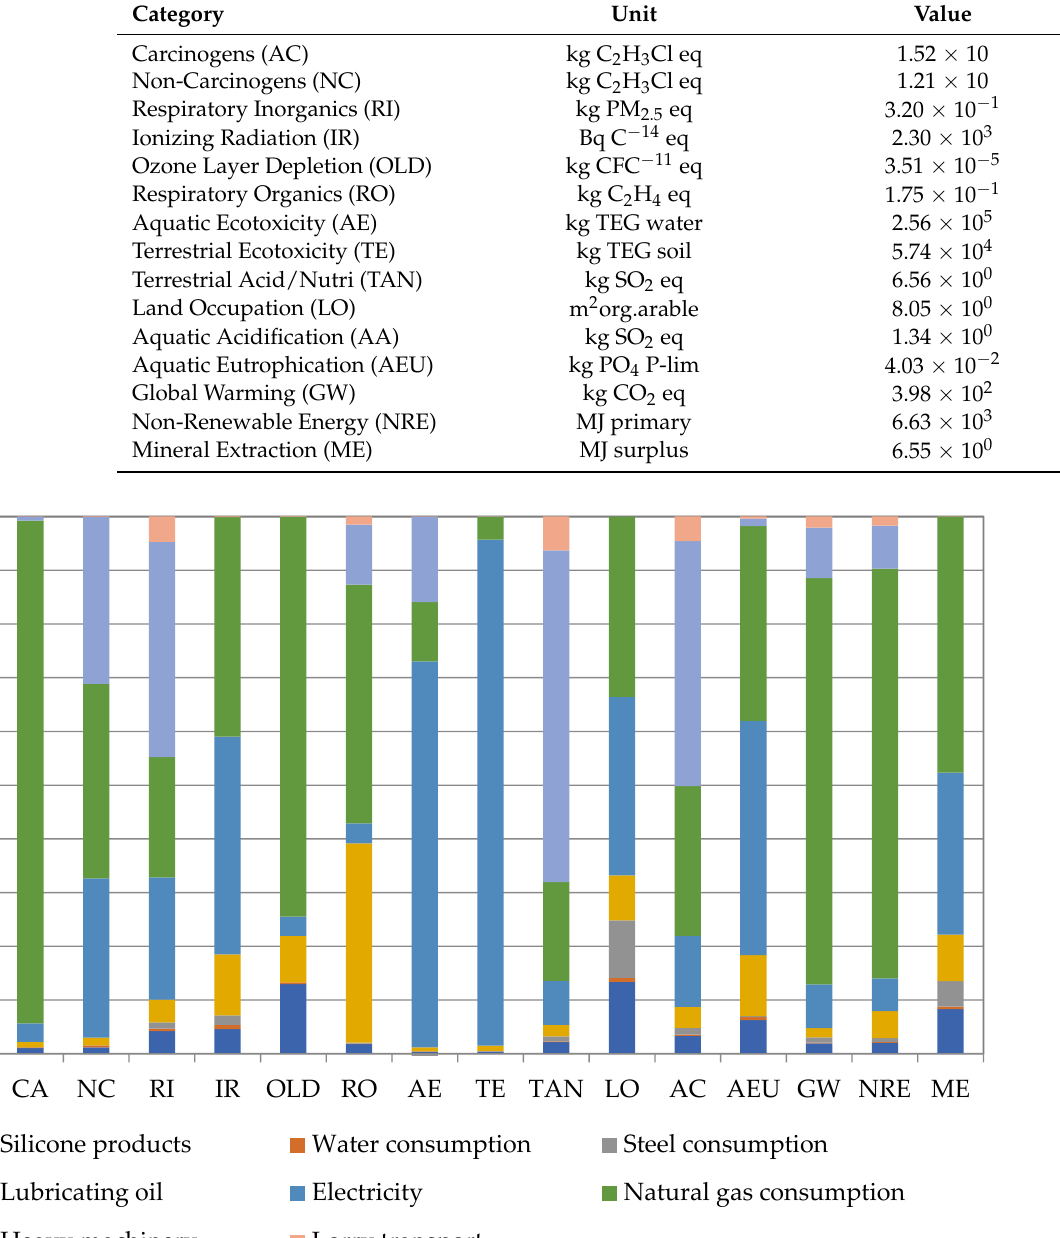
Table 5. LCA midpoint indicators.